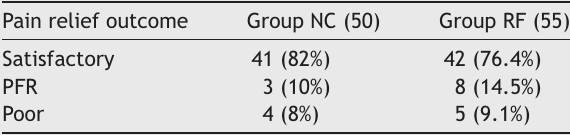
Surgical outcome of group NC vs. group RF